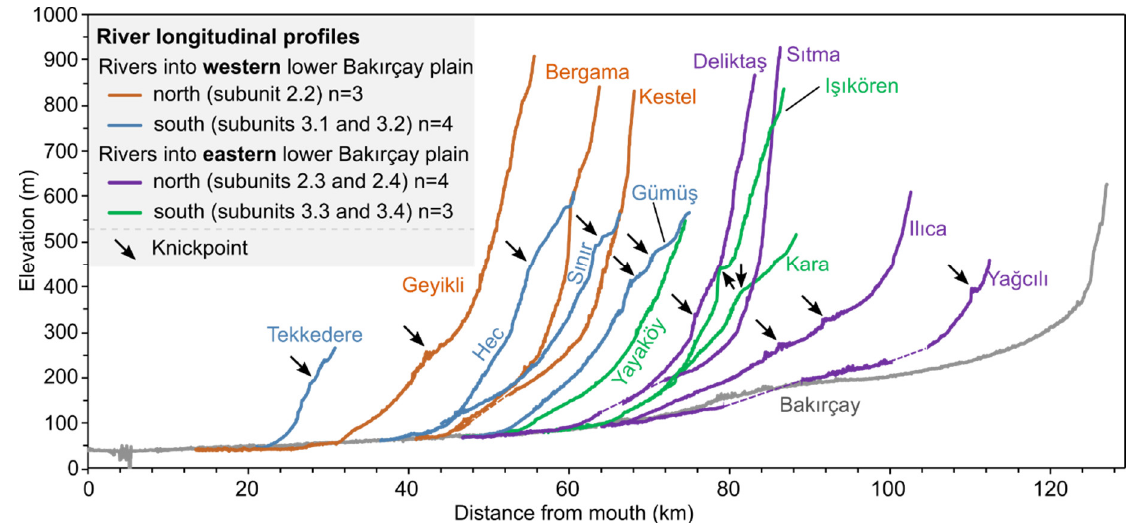
Figure 8. Longitudinal profiles of channel courses and major knickpoints in the Northern Highlands (geomorphological subunits 2.2–2.4) and Yunt Dağı Mountains (geomorphological subunits 3.1–3.4) enclosing the lower Bakırçay plain (see Figure 4 for the river courses). Note: c. 50× vertical exaggeration; reservoirs were manually modified with dashed lines.